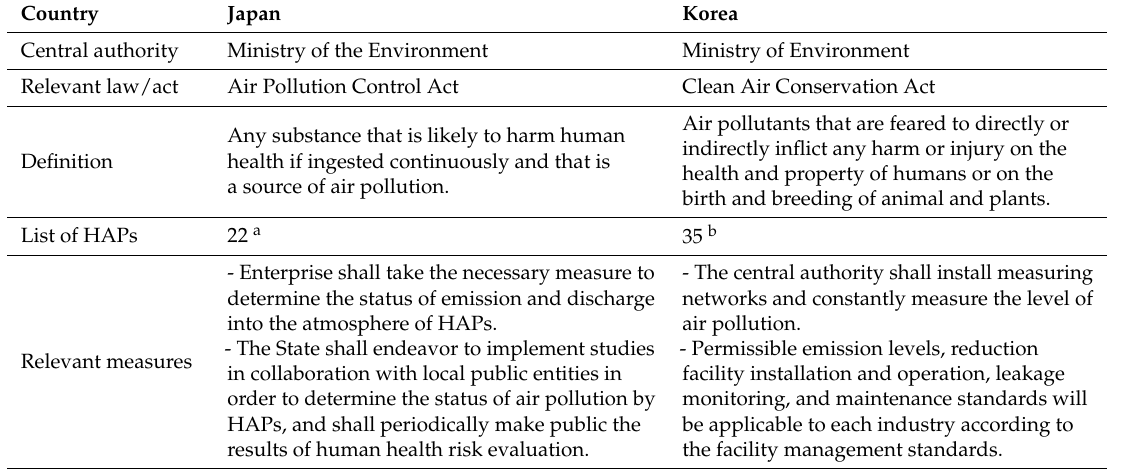
Table 1. Summaries of regulations for hazardous air pollutants (HAPs) in Korea and